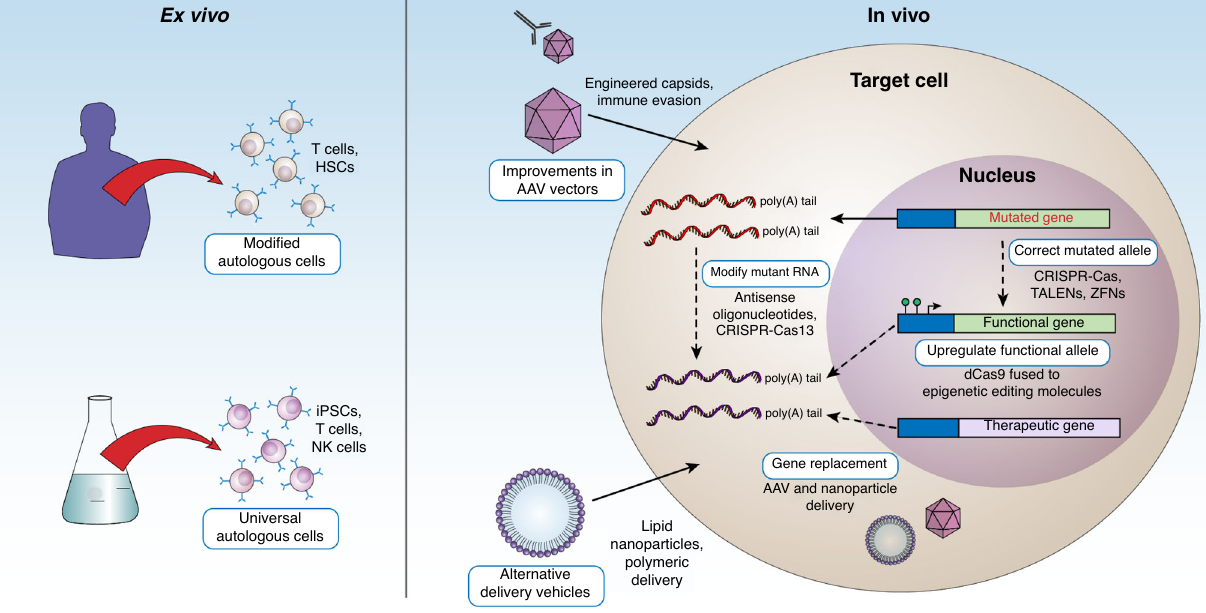
Fig. 2 Schematic of ex vivo and in vivo strategies (shown in blue boxes) for treating genetic diseases. For ex vivo approaches (left panel), autologous cells can be isolated directly from the patient and genetically modi fi ed to elicit a therapeutic effect, while allogeneic cells can be produced and readily available “ off the shelf. ” In vivo strategies require targeting of speci fi c cells in order to overexpress a therapeutic gene or correct pathological mechanisms to allow functional gene expression (dashed